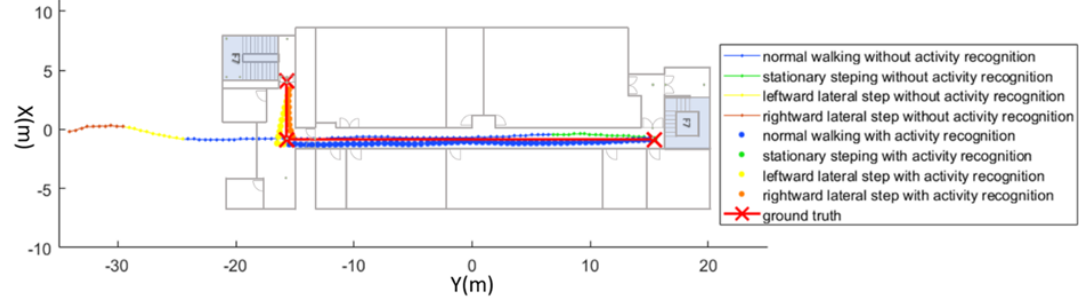
Figure 16. The positioning performance of lateral walking and stationary stepping on the 8th floor.